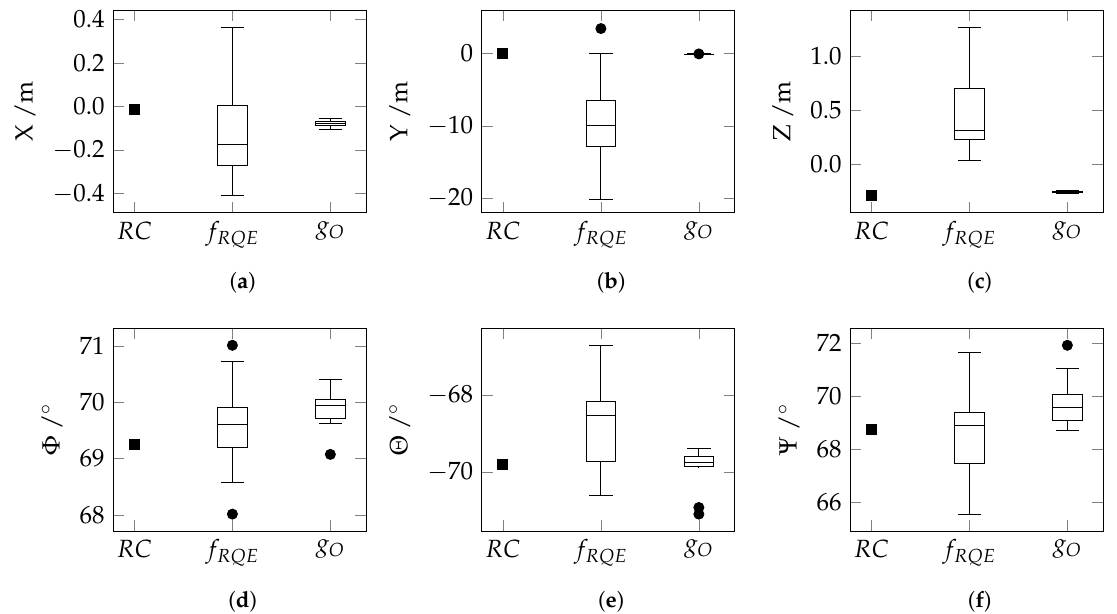
Figure 10. Calibration results of the reference calibration (RC), the self-calibration based on the RQE and our self-calibration based on the the feature of omnivariance for the large-scale outdoor dataset. ( a – c ) show the translation parameters, ( d – f ) show the rotation parameters. The estimation of the vertical component Y of the translation fails for the self-calibration based on RQE . The estimation of the calibration parameters is more precise for the self-calibration based on the omnivariance g O , however, Φ and Ψ is estimated with a larger deviation from the reference